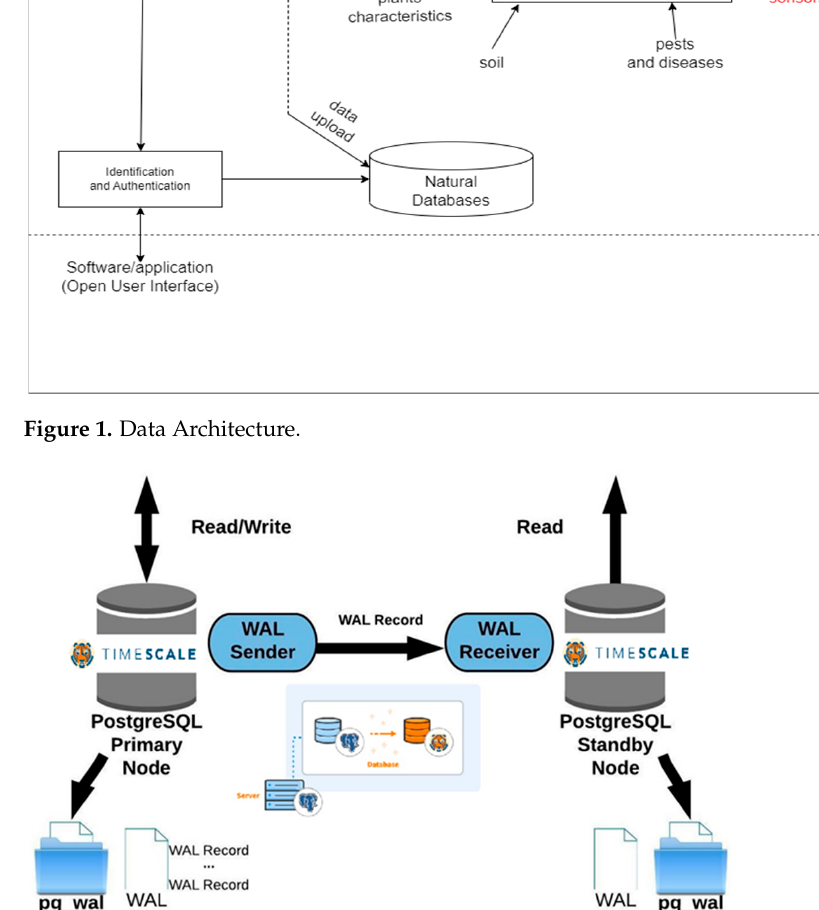
Figure 3. Replica set in MongoDB. If the sensor data grows signi fi cantly over time, we are planning to use sharding for the MongoDB data. Horizontal scaling allows almost unlimited scaling for the processing of large amounts of data and intensive workloads. Last but not least, we should mention backup planning for all databases and con fi g- uration items in the IT infrastructure of the regional center. 5. The Local Level of the Infrastructure Here, we will brie fl y present the current state of the sensor level. The fi rst sensor network is being built for open wheat blocks on the territory of the Institute of Plant Ge- netic Resources in the town of Sadovo. The experimental setup consists of multiple sen- sors used to monitor soil, leaf wetness, and air properties. The sensors that we are using are given in Table 1. Table 1. Sensor summary and reporting values. Sensor